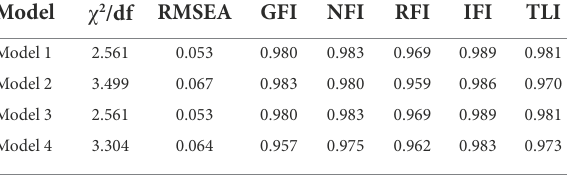
TABLE 11 Fitting indicators of each mediation